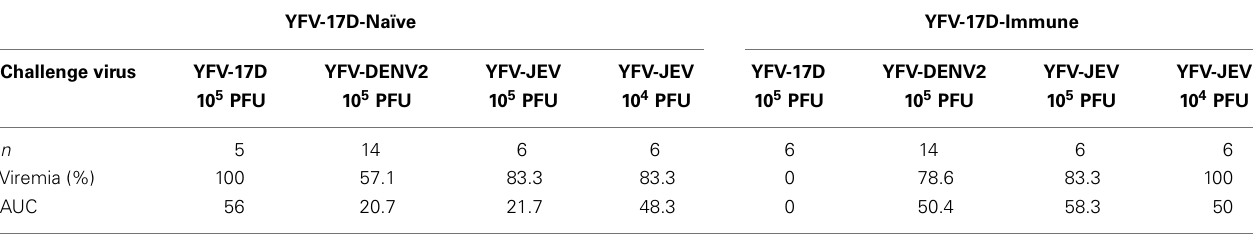
Table 1 |Analysis of viremia in human subjects with or without pre-existing antiviralT cell memory* . YFV-17D-Naïve